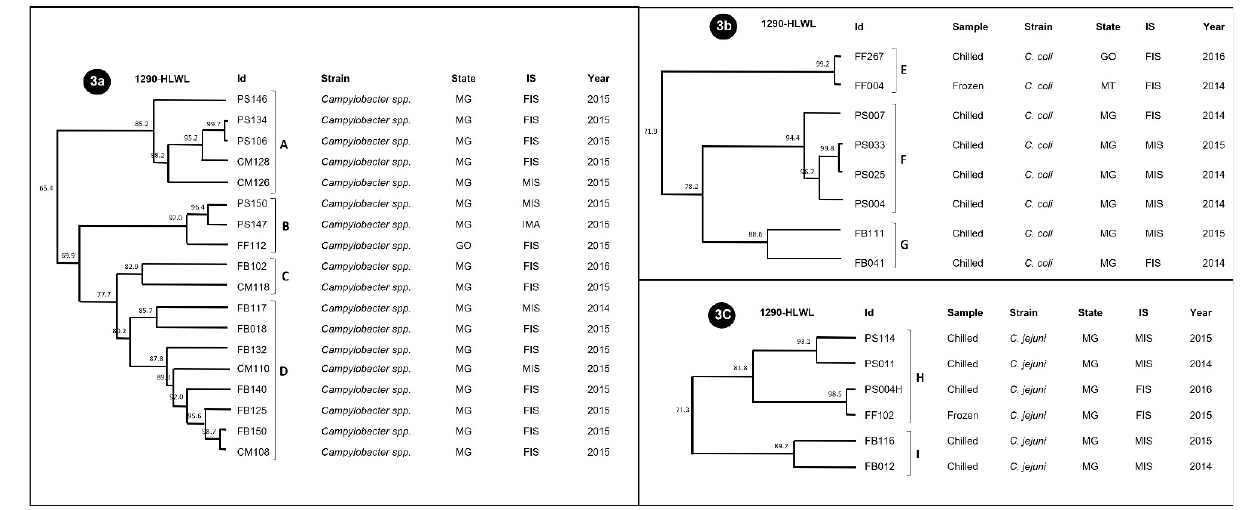
Figure 3. Comparative dendrogram of 32 Campylobacter strains for other meat matrices using the Dice similarity coefficient with 1% tolerance and the UPGMA method with 0.80% optimization. ( 3a ) Analysis of Campylobacter spp.; ( 3b ) Analysis of C. coli ; ( 3c ) Analysis of C. jejuni . (A–I) clusters formed with homology greater than 80%. CM—ground bovine duckling; FB—bovine liver; FF—chicken liver; PS—pork shank. SP (São Paulo), MT (Mato Grosso) and MG (Minas Gerais).